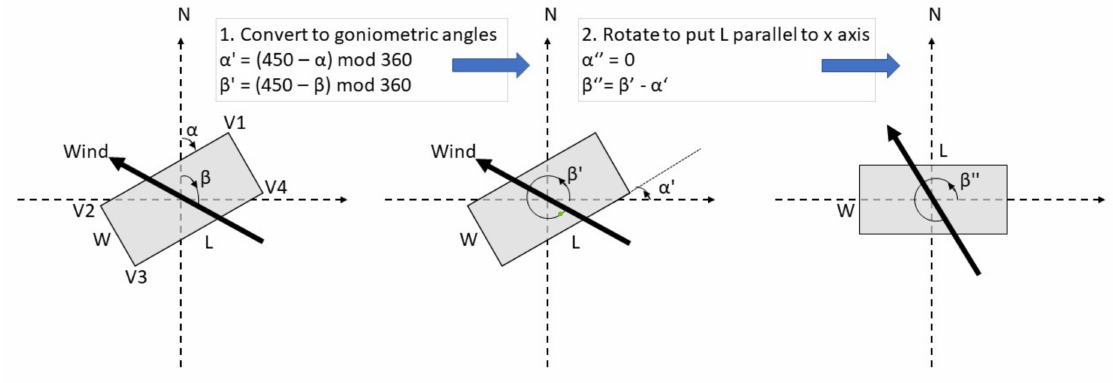
Figure 3. Path calculation when wind crosses the longest size of the tank